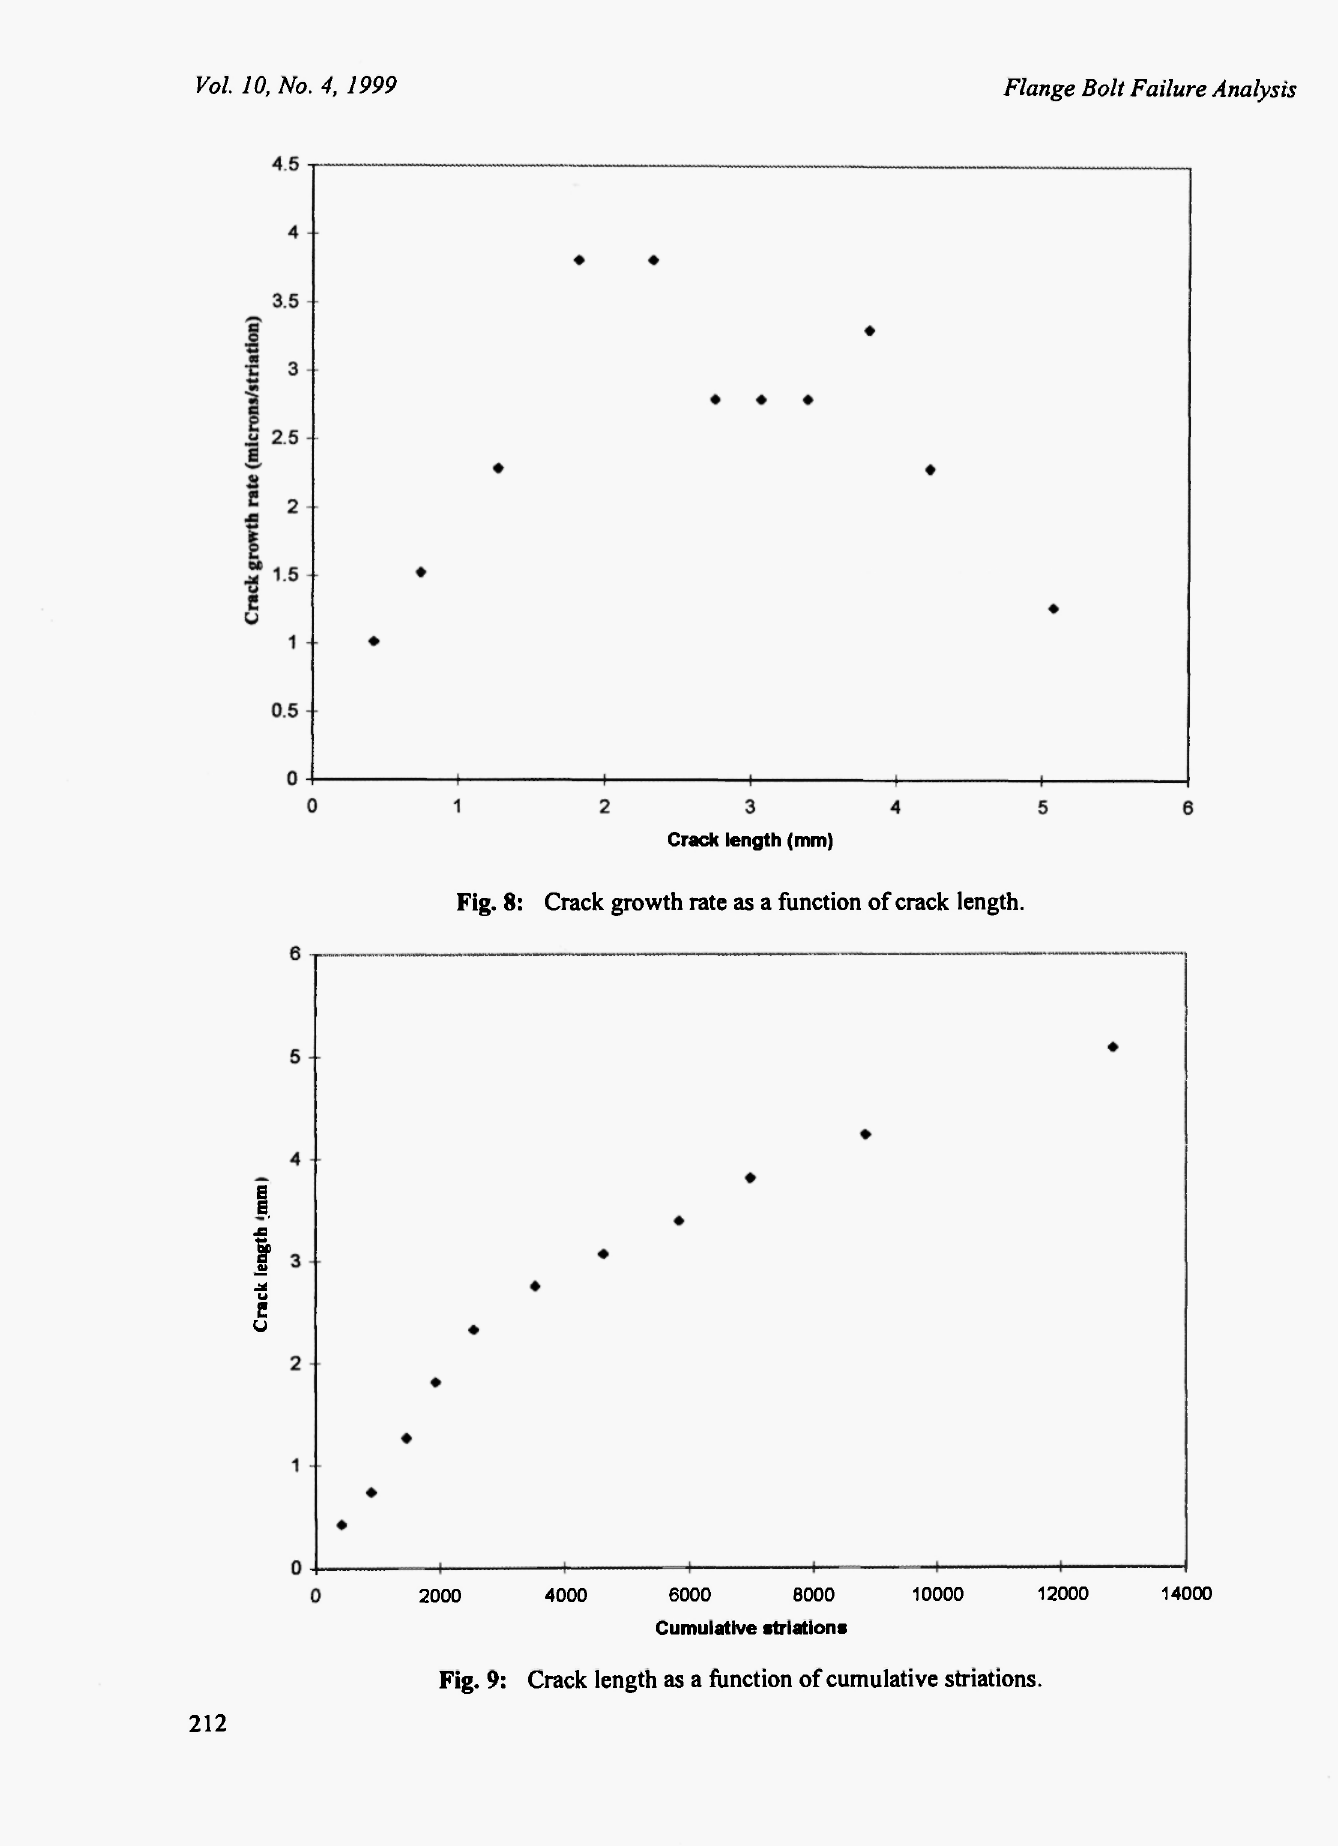
Fig. 8: Crack growth rate as a function of crack length.